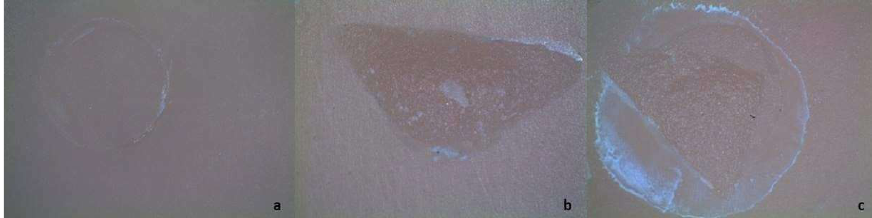
Figure 2. Stereomicroscopy photographs of the representative fracture patterns. Adhesive ( a ), cohesive ( b ), mix ( c